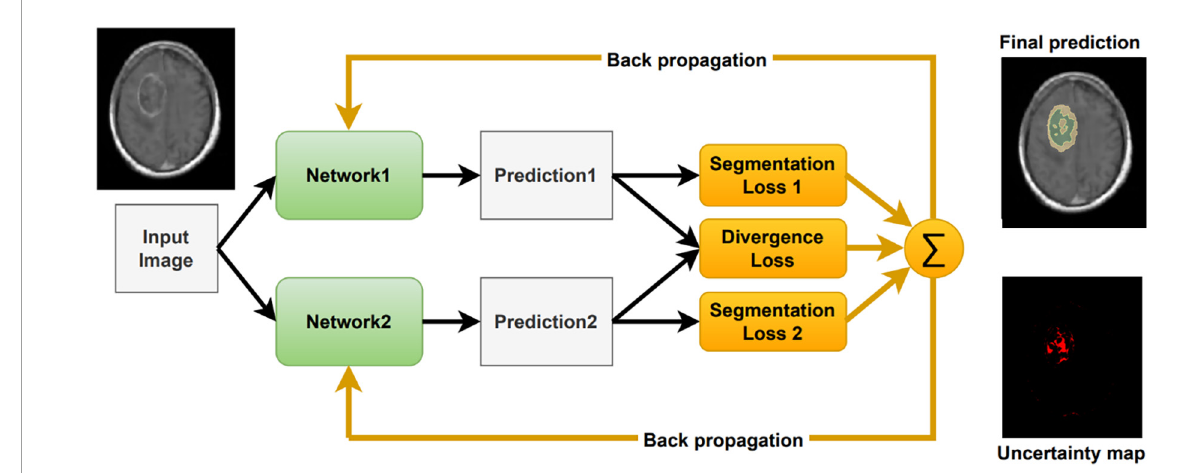
FIGURE2 Our model architecture incorporating uncertainty as computed by the divergence loss.